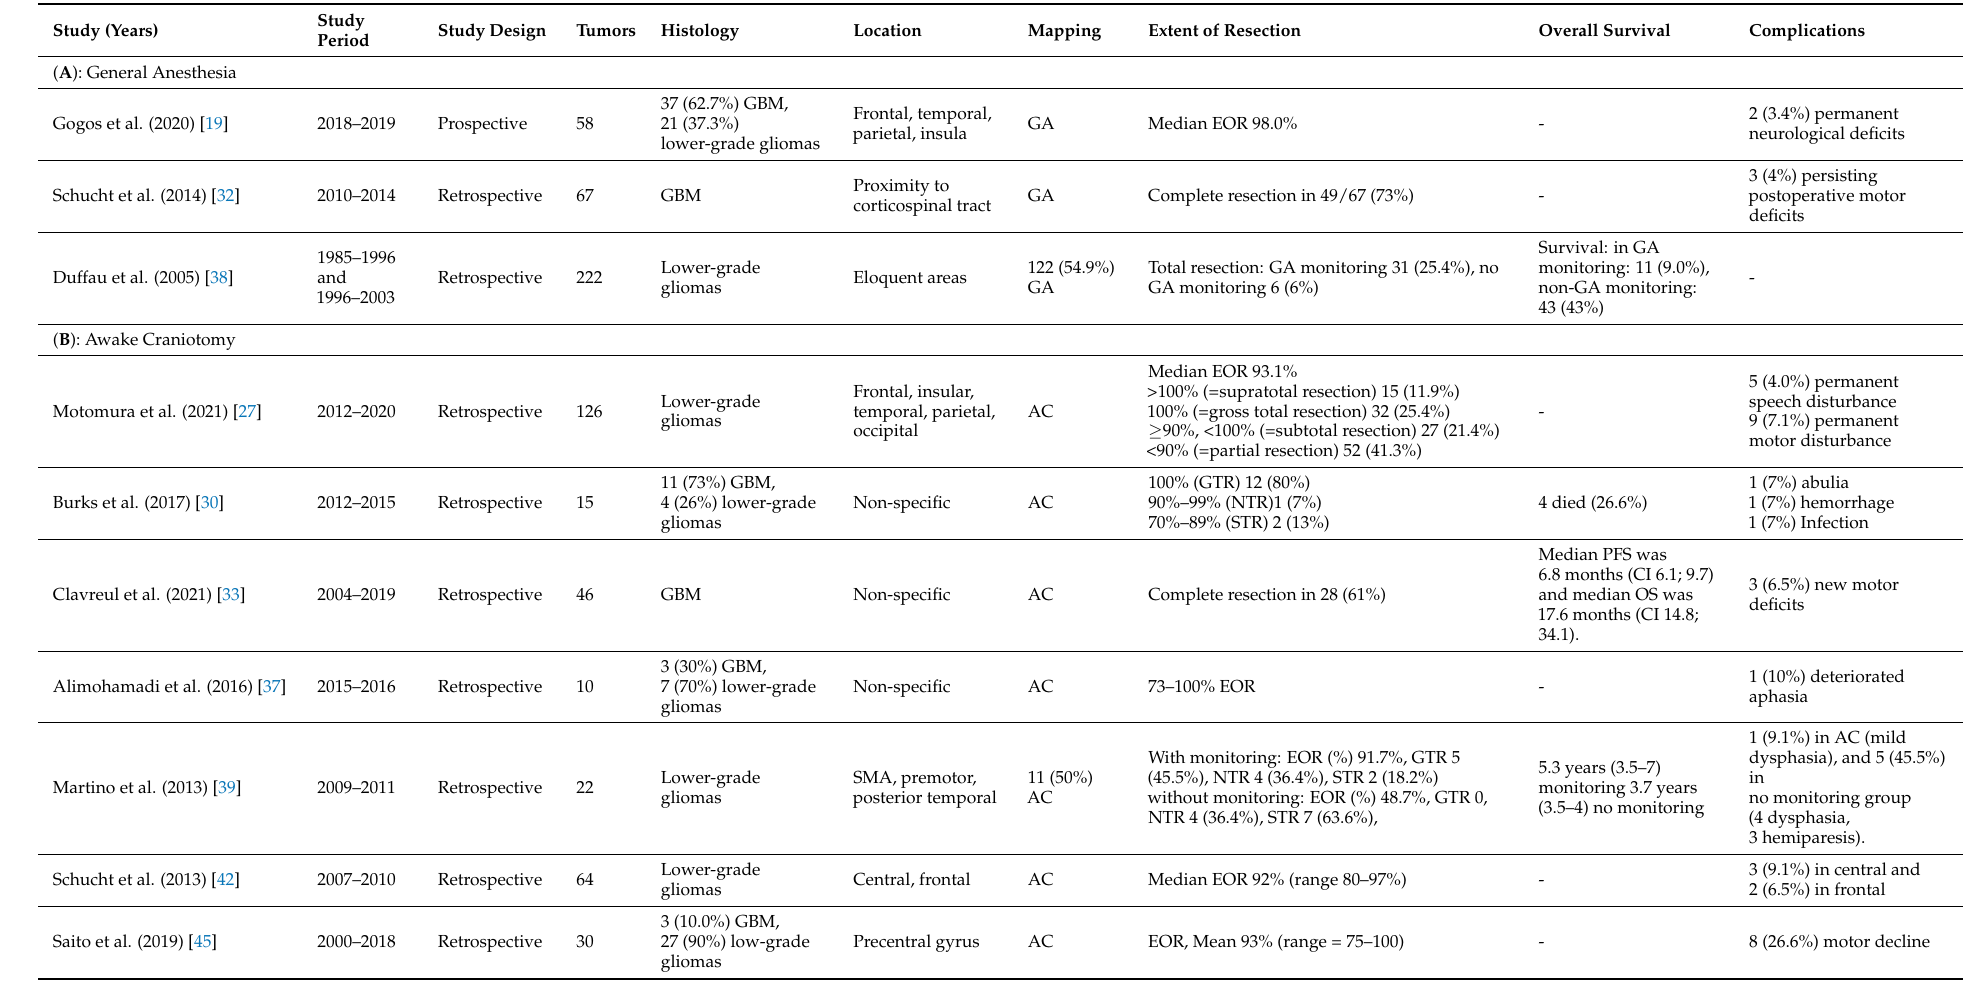
Table 2. ( A – C ) Studies investigating the role of intraoperative mapping through awake and general anesthesia monitoring in improving the extent of resection: ( A ) general anesthesia; ( B ) awake craniotomy; ( C ) general anesthesia and awake